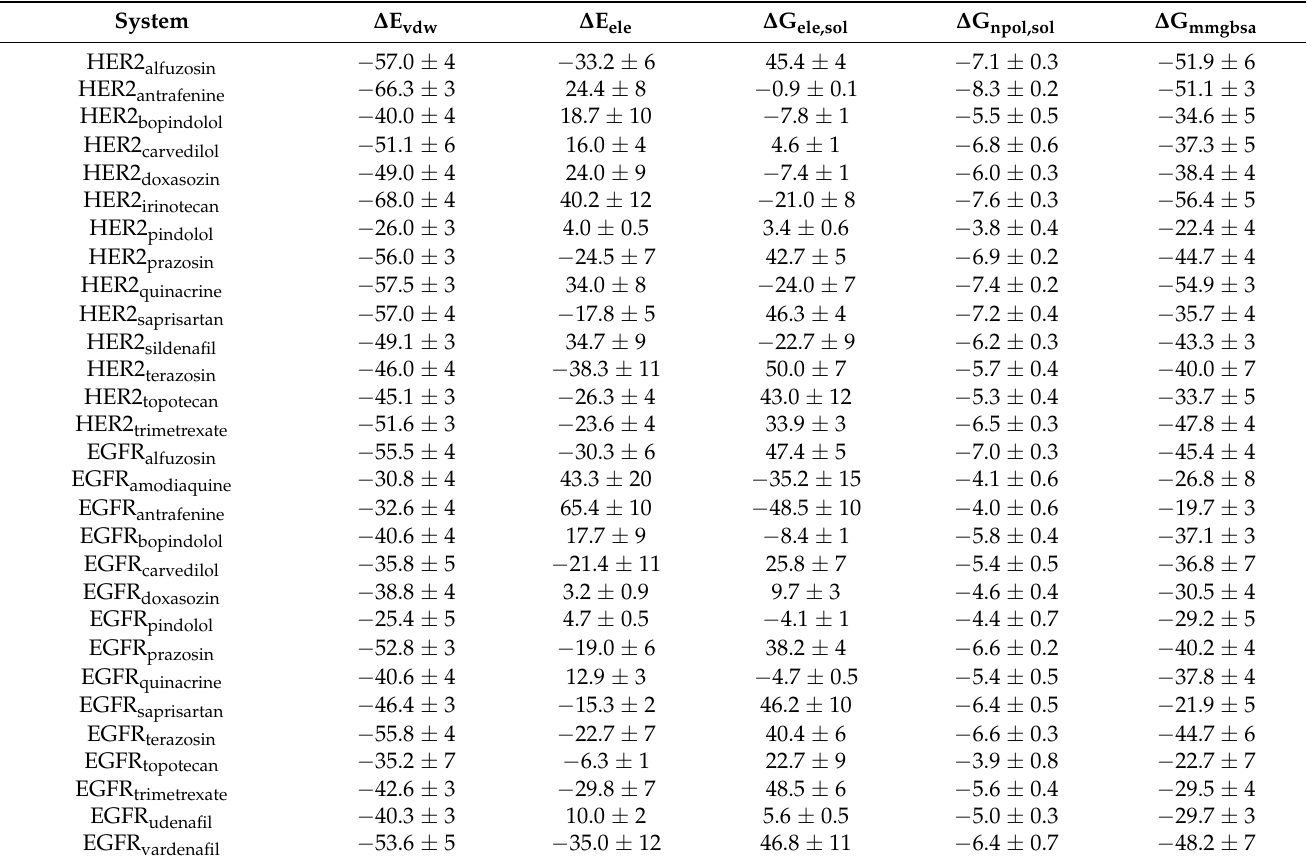
Table 3. Binding affinity for the protein-ligand systems (in units of